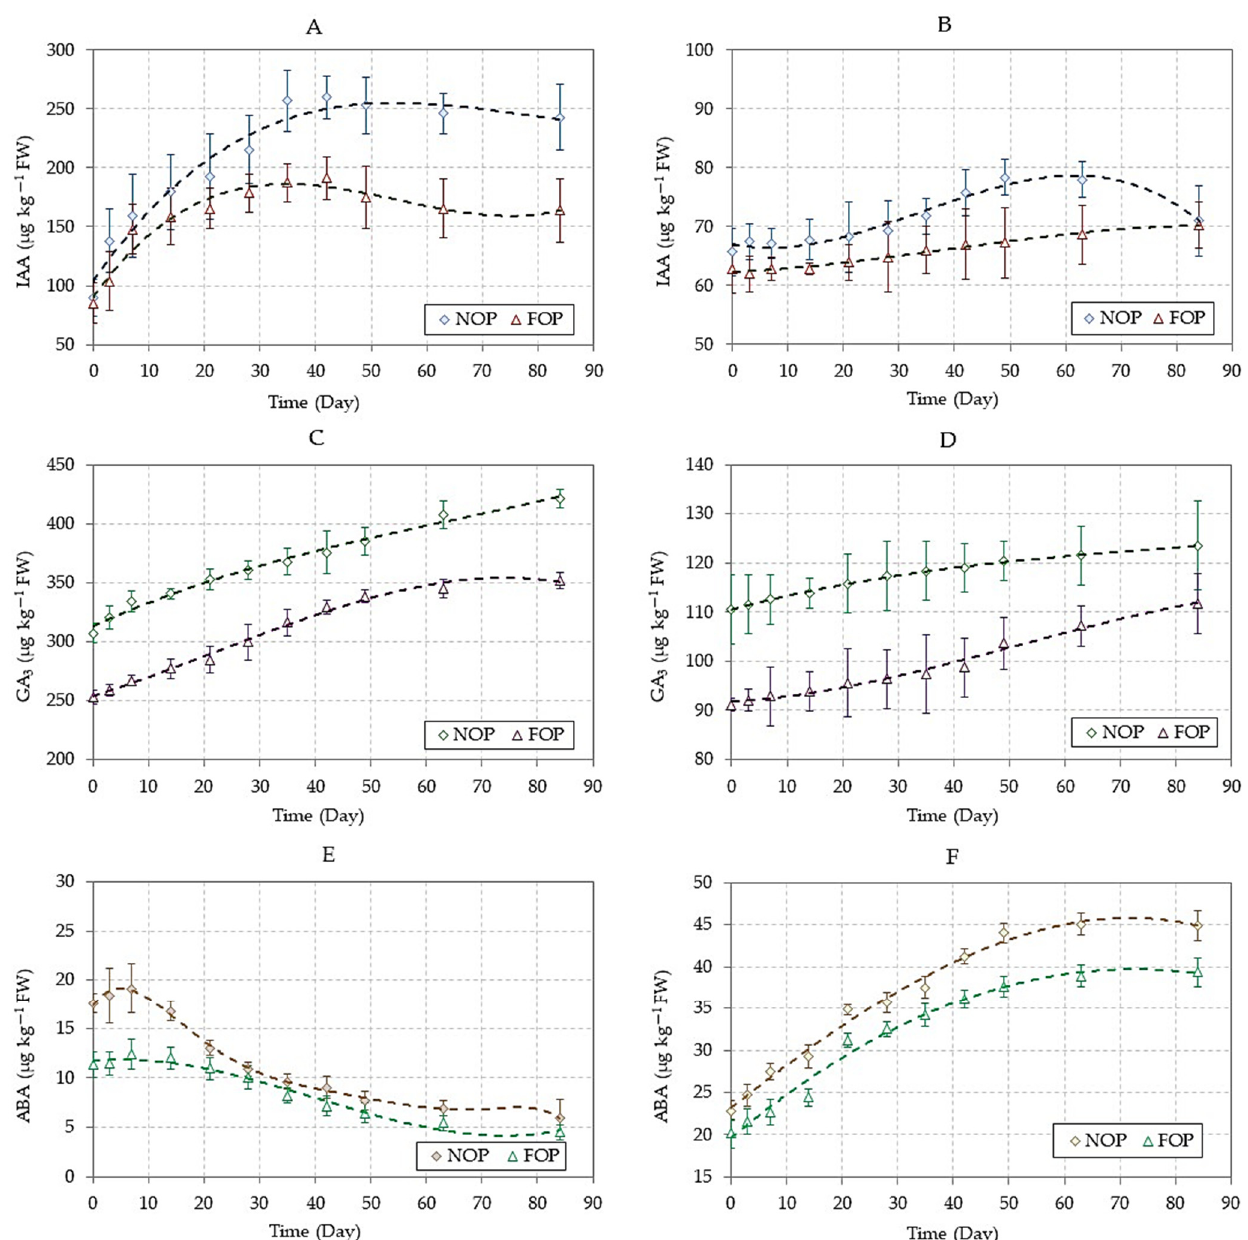
Figure 2. The data represent mean values ± SD of IAA content under normal pollination type ( A ) and forced pollination type ( B ) (LSD0.05 = 16.514), GA3 content under normal pollination type ( C ) and forced pollination type ( D ) (LSD0.05 = 19.292), and ABA content under normal pollination type ( E ) and forced pollination type ( F ) (LSD0.05 = 1.891) at different times from 0 to 84 days after pollination for tissue culture and offshoot-derived date palms of 6-year-old palm trees.